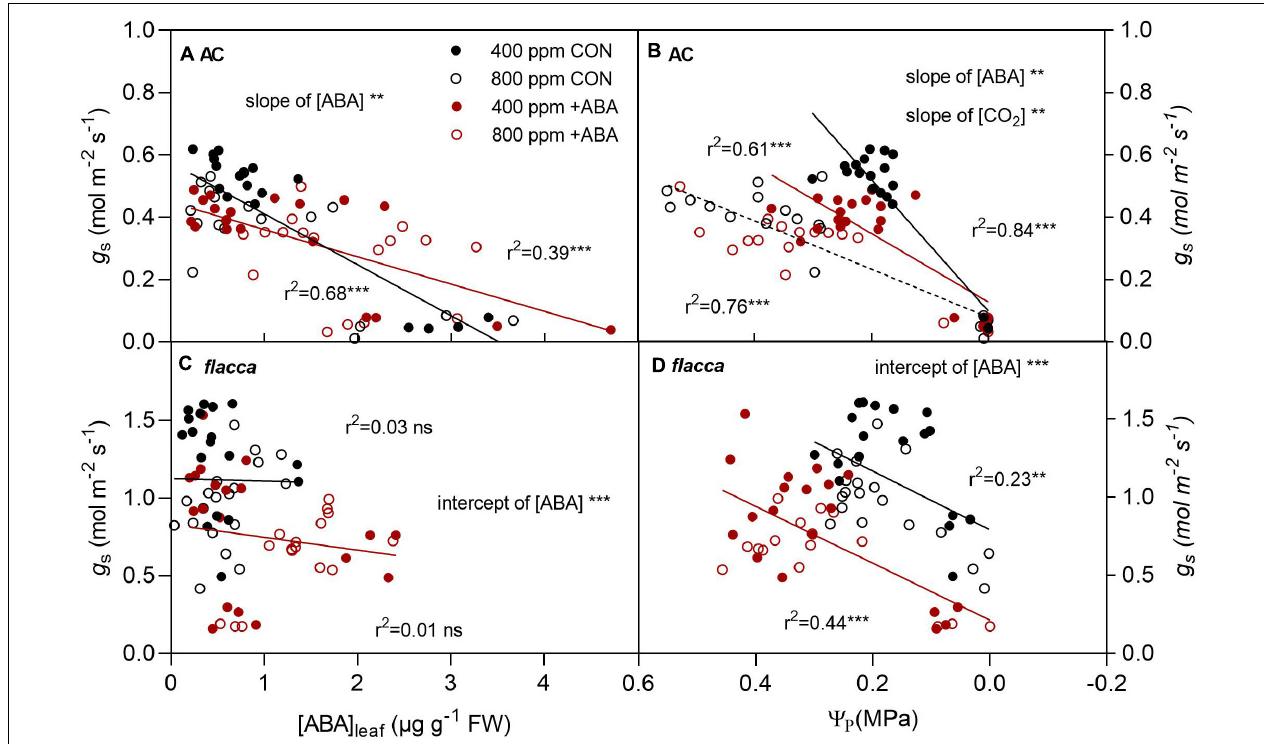
FIGURE 8 | Relationships between stomatal conductance ( g s ) and leaf ABA concentration ([ABA] leaf ), g s and turgor pressure ( (cid:57) p ) in AC (A,B) and flacca (C,D) grown under ambient (400 ppm) and elevated (800 ppm) CO 2 during soil drying. CON indicates the control treatment sprayed with water, +ABA indicates exogenous ABA application. ** and *** indicate significant differences in the regression lines and significant differences of the slopes and intercepts between treatments at p < 0.01 and p < 0.001, respectively; ns denotes no significant difference. Black and red lines (denote CON and +ABA, respectively) indicated that there were significant differences between [ABA] treatments. Solid and dotted black lines in panel (B) indicated that only under CON but not +ABA there was a significant difference between [CO 2 ]